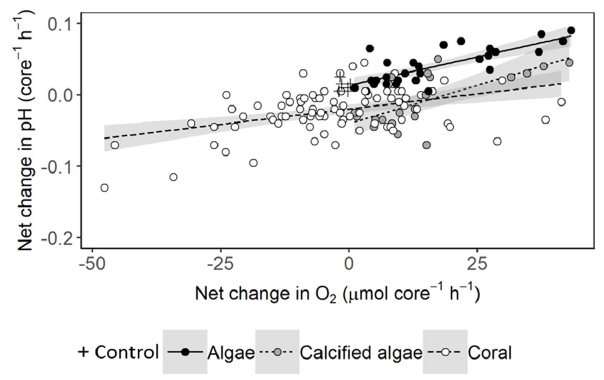
Figure 5. Net change in pH versus O 2 per 1.56L incubation core, assuming equal periods of light and darkness. Linear relationships are fitted with 95% confidence intervals shown in grey. For algae, net change in pH = 0.13 + 0.0016 × net change in O 2 (ANOVA: F 1 , 27 = 41.15, p < 0.001). For calcified algae, net change in pH =− 0.04 + 0.0021 × net change in O 2 (ANOVA: F 1 , 19 = 17.86, p < 0.001). For corals, net change in pH =− 0.02 + 0.00086 × net change in O 2 (ANOVA: F 1 , 82 = 18.88, p <